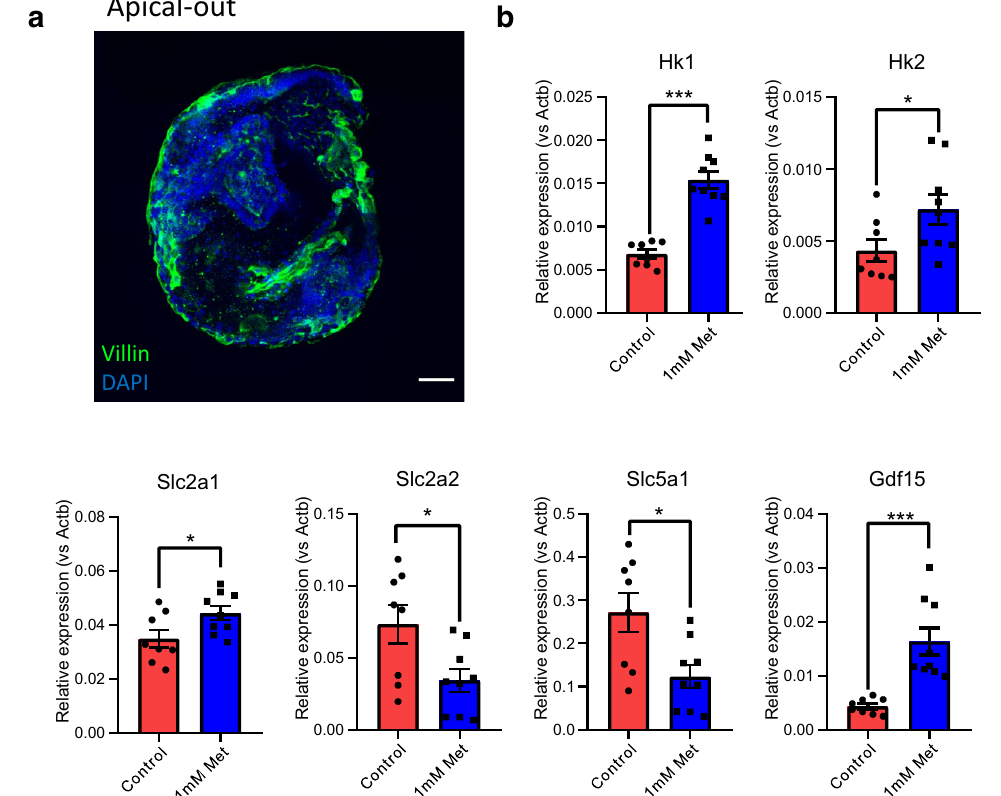
Figure 7. The effects of metformin on gene expression changes in apical-out and basal-out intestinal organoids. ( a ) Confocal images of mouse apical-out intestinal organoids stained with villin (green) and DAPI (blue). Scale bar = 30 µm. ( b ) qPCR analysis of glucose transporters ( Slc5a1 , Slc2a2 and Slc2a1 ), hexokinases ( Hk1 and Hk2 ) and Gdf15 in mouse duodenal apical-out organoids in response to metformin pre-treatment of 1 mM for 24 h. n = 8–9 wells from 3 independents. Results are mean ± SEM. *P < 0.05, **P < 0.01, ***P < 0.001. One way ANOVA and Bonferroni post-hoc